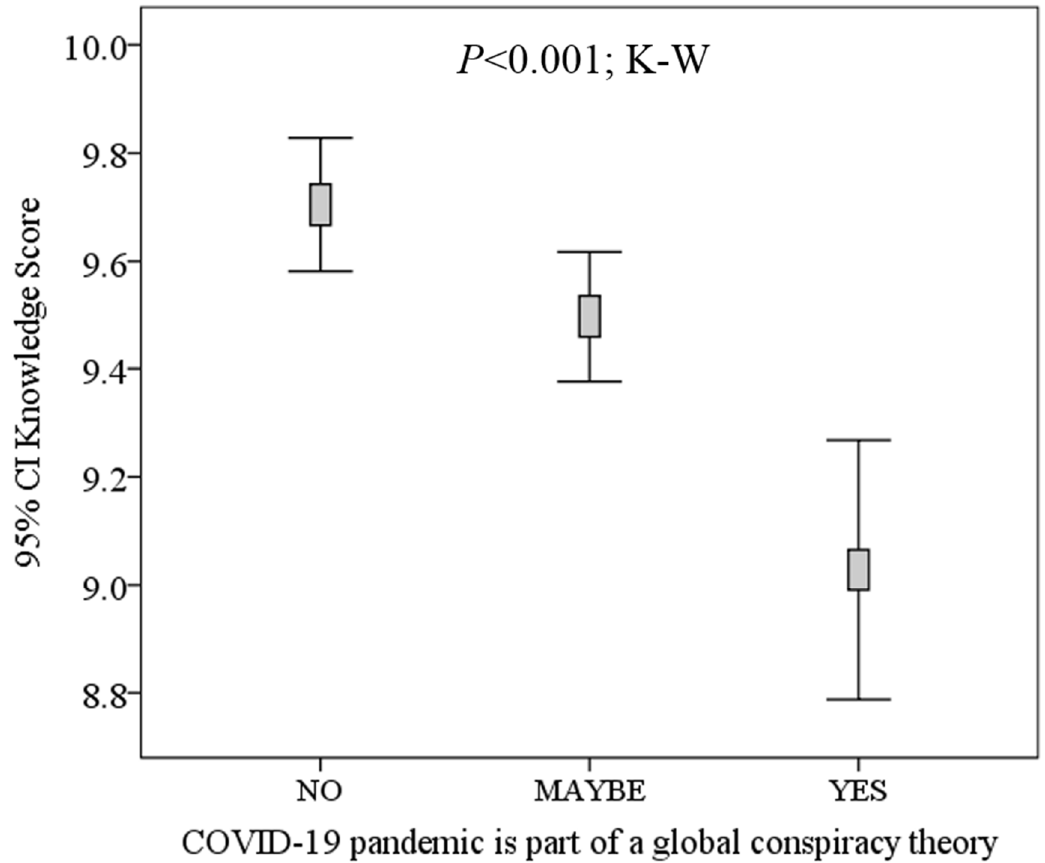
Figure 2. Correlation between students’ knowledge about COVID-19 and their belief in a conspiracy role in the disease. Participants were students at the University of Jordan. K–W: Kruskal–Wallis test. CI: confidence interval.